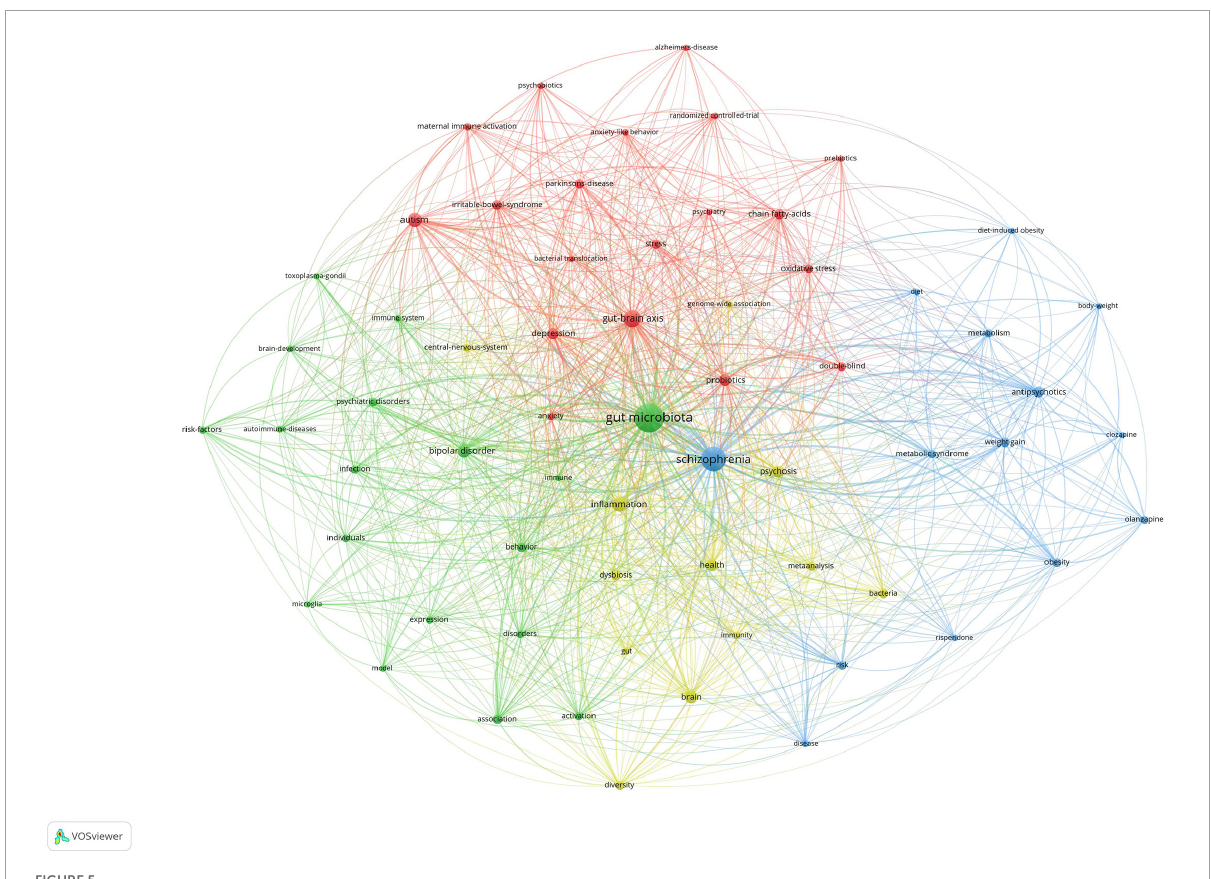
FIGURE5 Visualization of keyword co-occurrence